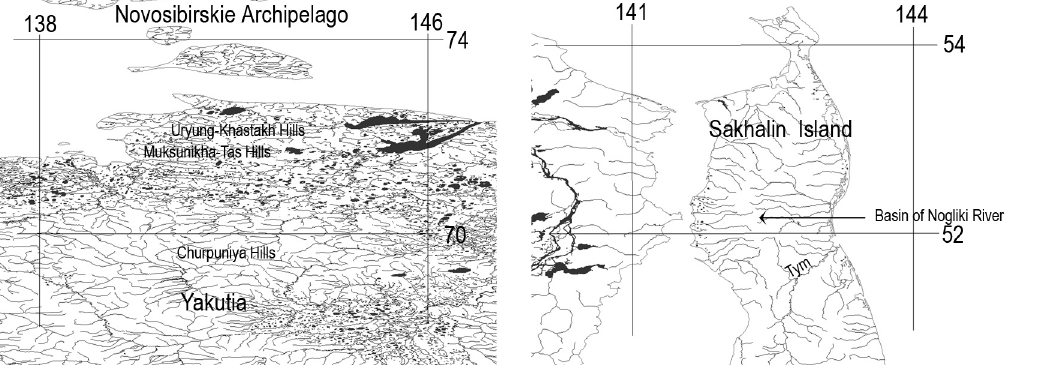
Fig. 19. Map of Basin of Nogliki River calving grounds.